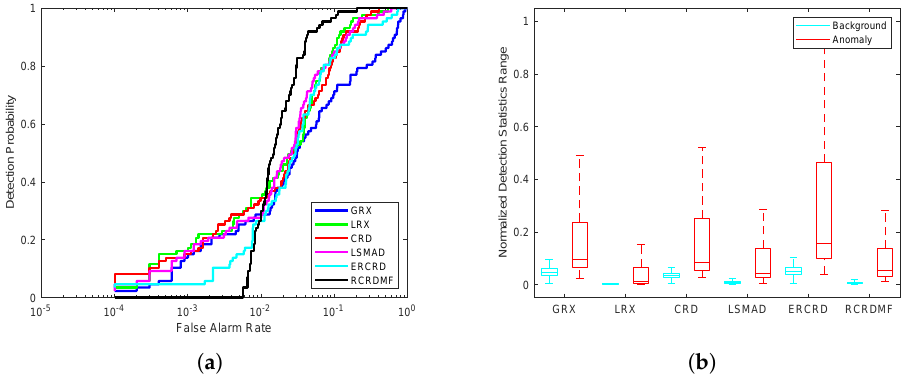
Figure 14. Detection accuracy evaluation for the abu-airport-2 dataset. ( a ) ROC curves. ( b ) Normal- ized background-anomaly separation